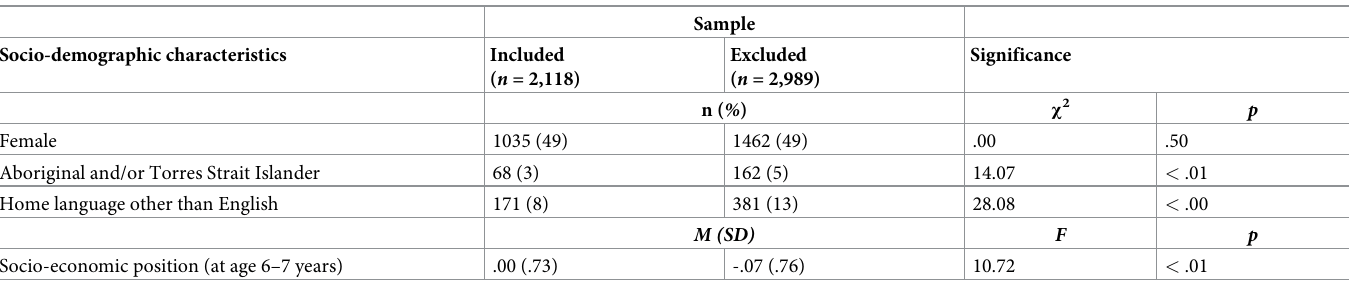
Table 1. Sample demographics of selected and excluded